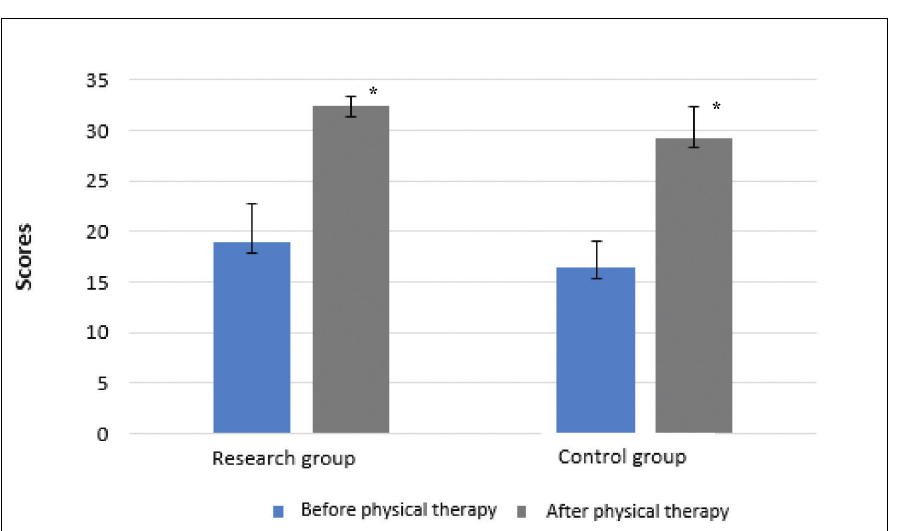
Figure 4. Postural Assess- ment Scale for Stroke value in Group 1 and Group